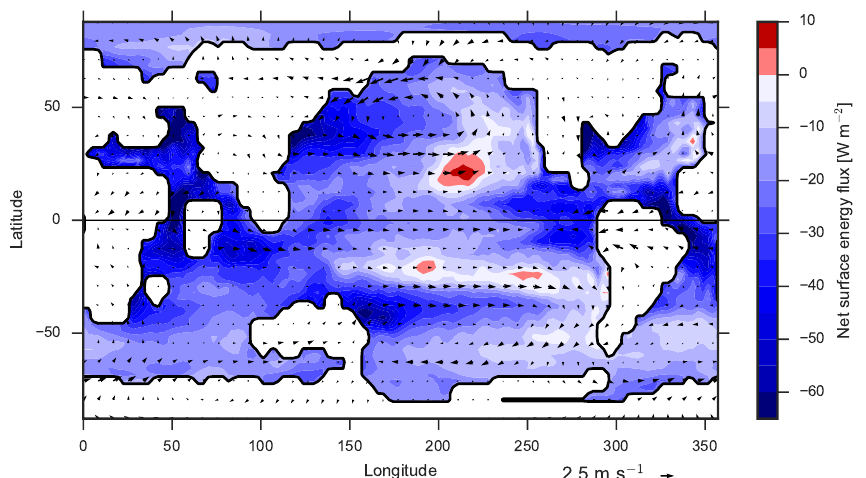
Figure 7. Change in annual-mean net surface energy flux (shading, defined positive downwards) and 900hPa wind (arrows) between the GHG run and the fixed-SST run with reduced CO 2